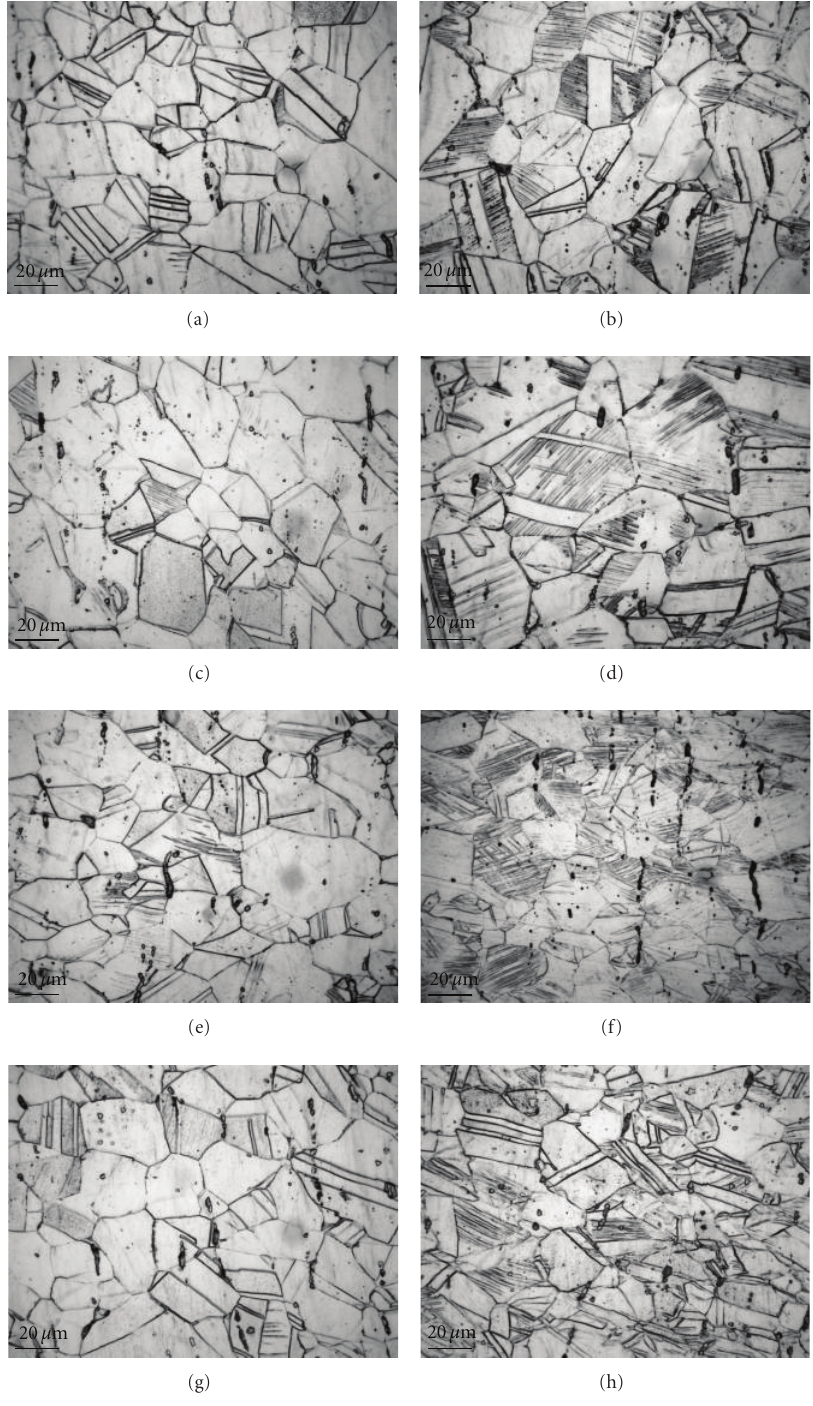
Figure 10: Metallographic images of 316L stainless steel specimens deformed at (a) 25 ◦ C and 1 × 10 3 s − 1 ; (b) 25 ◦ C and 5 × 10 3 s − 1 ; (c) 200 ◦ C and 1 × 10 3 s − 1 ; (d) 200 ◦ C and 5 × 10 3 s − 1 ; (e) 400 ◦ C and 1 × 10 3 s − 1 ; (f) 400 ◦ C and 5 × 10 3 s − 1 ; (g) 800 ◦ C and 1 × 10 3 s − 1 ; (h) 800 ◦ C and 5 × 10 3 s − 1